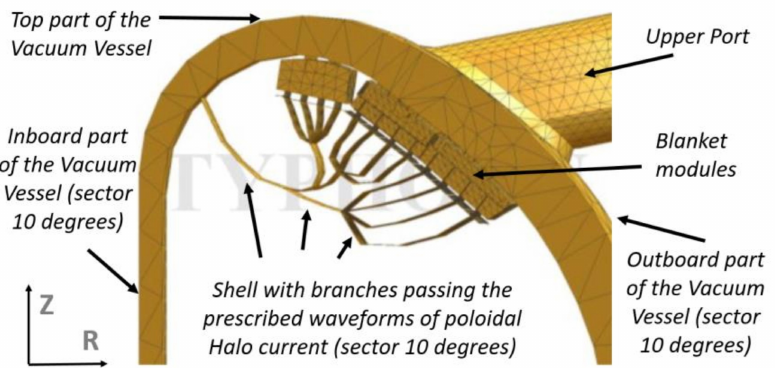
Figure 2. Since ITER EDA times [3], many EM postprocessing codes, e.g., [9], simulate the Halo layer as either one, or a few enclosed, or branching shells fixed in space and time and fed by waveforms of poloidal Halo current delivered by plasma evolution code. There is an example of the branching shell. This illustration is courtesy of authors